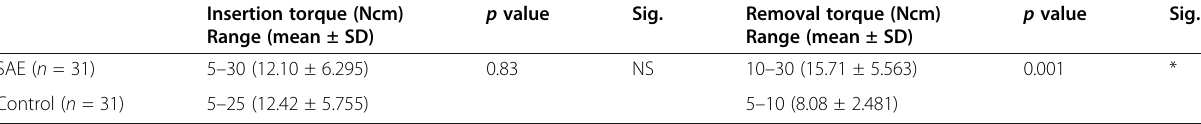
Table 2 Insertion and removal torque of orthodontic miniscrews in the study groups Insertion torque (Ncm) Range (mean ±